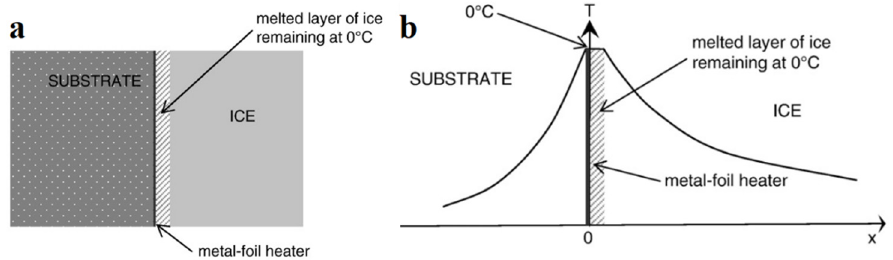
Figure 10. ( a ) Scheme of the anti-icing heating film on the substrate surface; ( b ) the temperature distribution at the interface after heating the film. Reprinted with permission from [66].